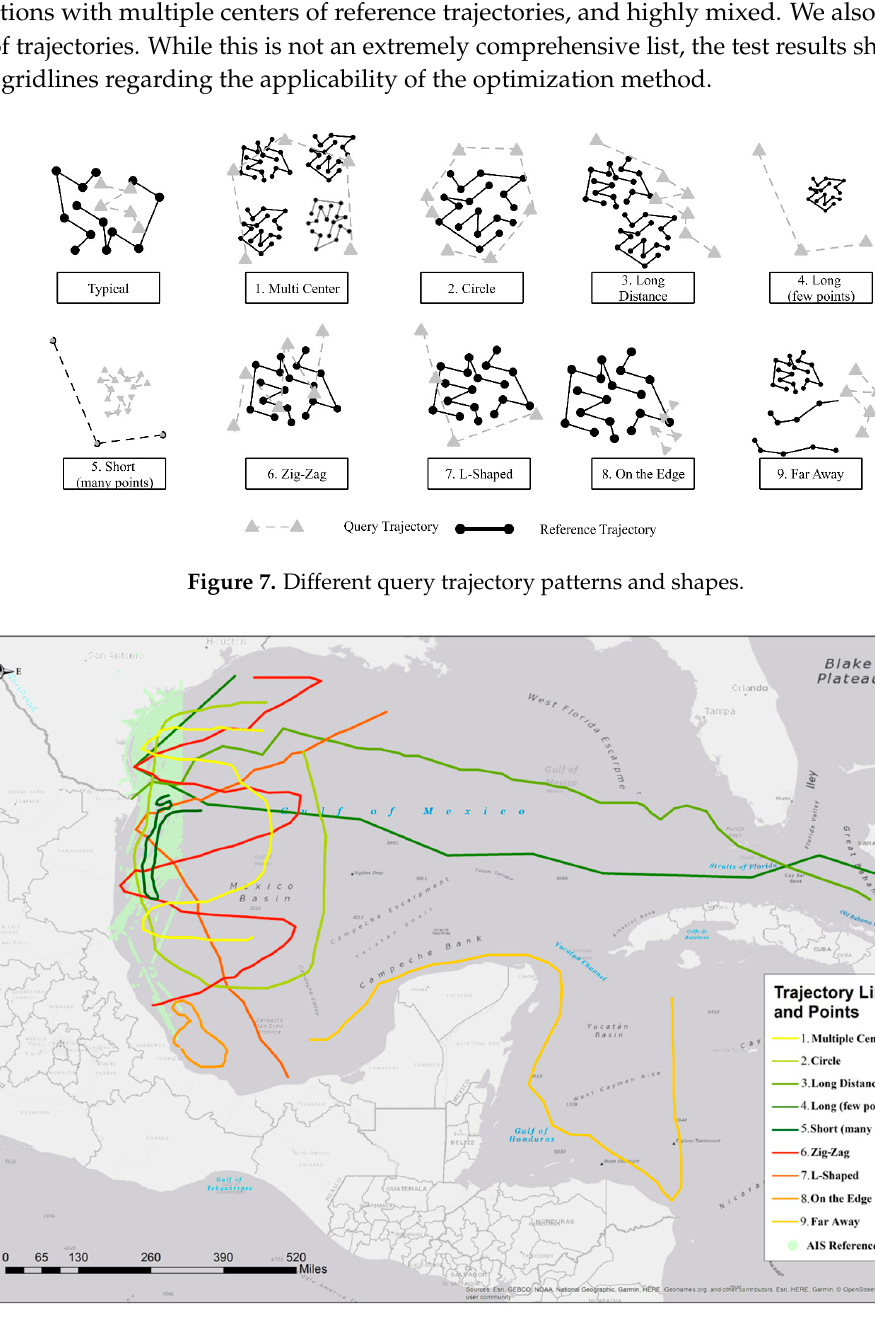
Figure 8. Distribution of query trajectories and points from reference trajectories.